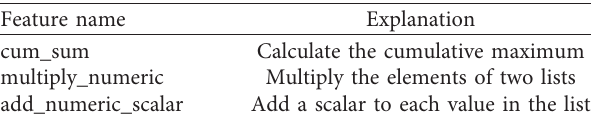
Table 3: Features generated through transformation.